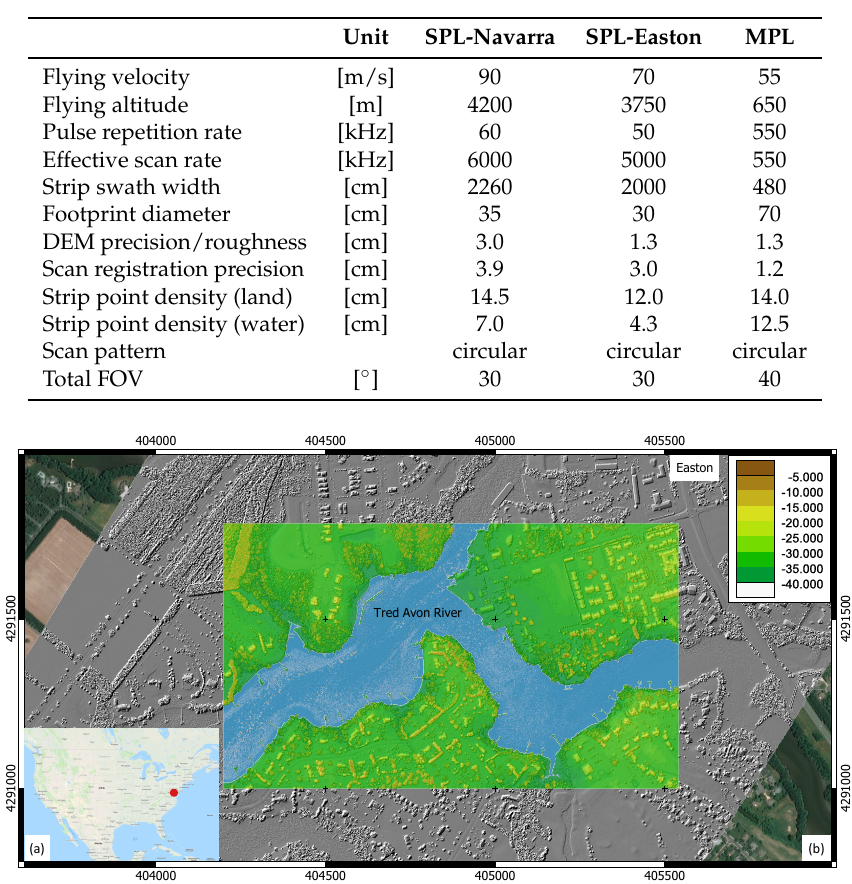
Table 3. Flight mission and qualitycontrol parameters for Single Photon LiDAR (SPL: Navarra, Spain and Easton, MD, USA) and Multi-Photon LiDAR (MPL: Neubacher Au, Austria).